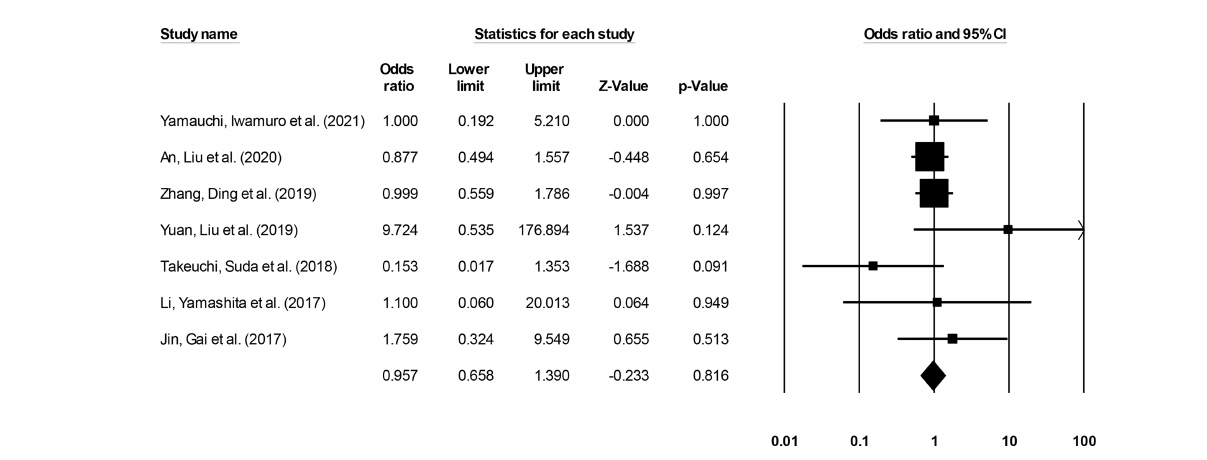
FIGURE 6 | The forest plot for studies evaluating the recurrence incidence in patients with super fi cial esophageal squamous cancer undergoing endoscopic submucosal dissection or esophagectomy. The odds ratios are presented as black boxes whereas 95% con fi dence intervals are presented as whiskers. A lower odds ratio represents higher risks of recurrence for patients receiving endoscopic submucosal dissection, and a higher odds ratio represents higher risks of recurrence for patients receiving